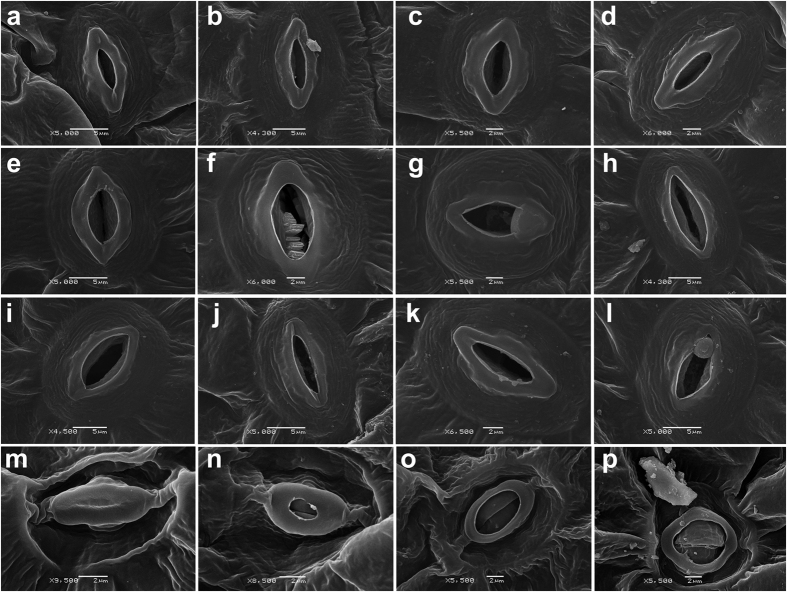
Scanning electron micrographs of stomatal guard cells of WT and tgg1 tgg2 double mutant.(a–d) WT. (e–h) tgg1 single mutant: the stomatal guard cells appear bigger. (i-l), tgg2 single mutant: the stomatal guard cells appear bigger. (m–p) tgg1 tgg2 double mutant: stomatal guard cells appear smaller, tightly closed and sunken showing variations as compared to the normal and open stomatal guard cells in the WT, and tgg1 and tgg2 single mutants. (a,b,e,h–j,l) (Scale bars, 5 μm). (c,d,f,g,k,m–p) (Scale bars, 2 μm).